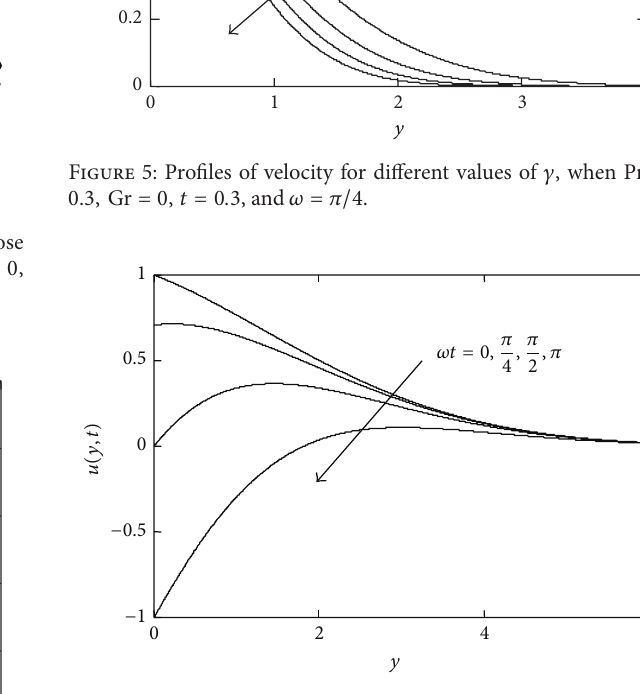
Figure 6: Profiles of velocity for different values of 𝜔𝑡 , when Gr = 3 , Pr = 0.3 , 𝑡 = 1 , and 𝛾 = 0.5